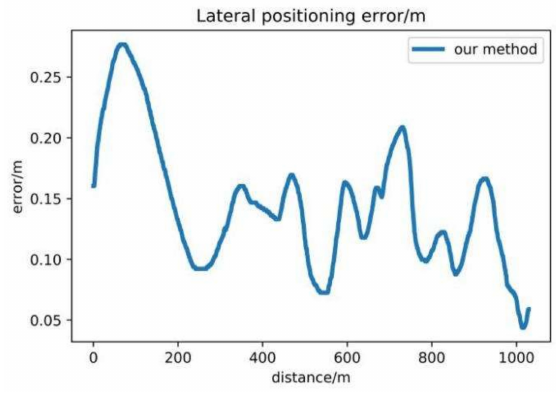
Figure 16. Tunnel positioning transverse tangent